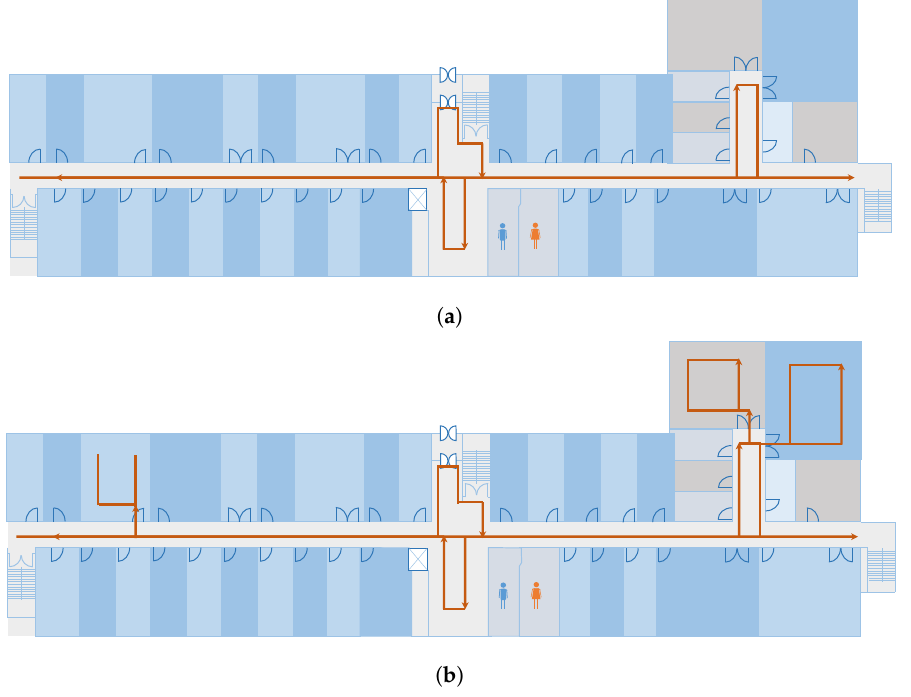
Figure 9. The path used for the experiments for, ( a ) Scenario 1 and ( b ) Scenario